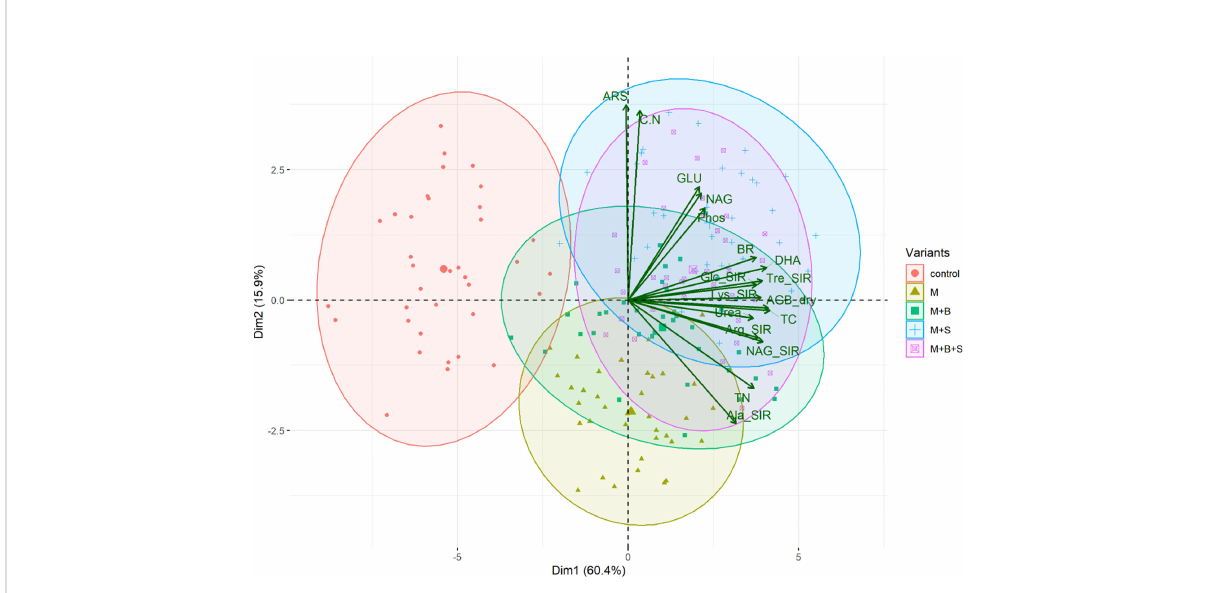
FIGURE 6 The PCA biplot of the soil